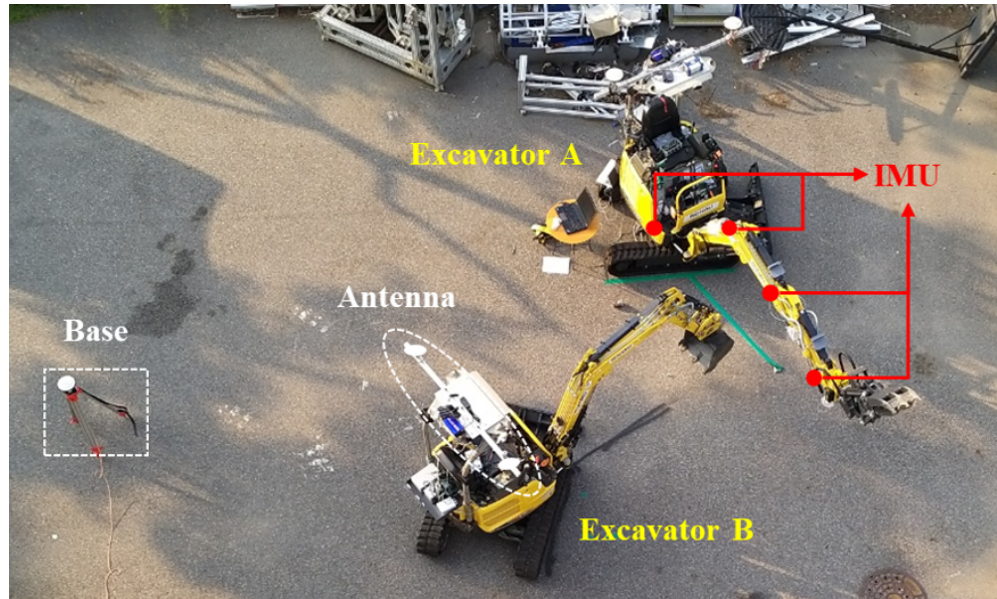
Figure 16. Experimental set-up: Two excavators, GNSS, IMU devices, and communication system.